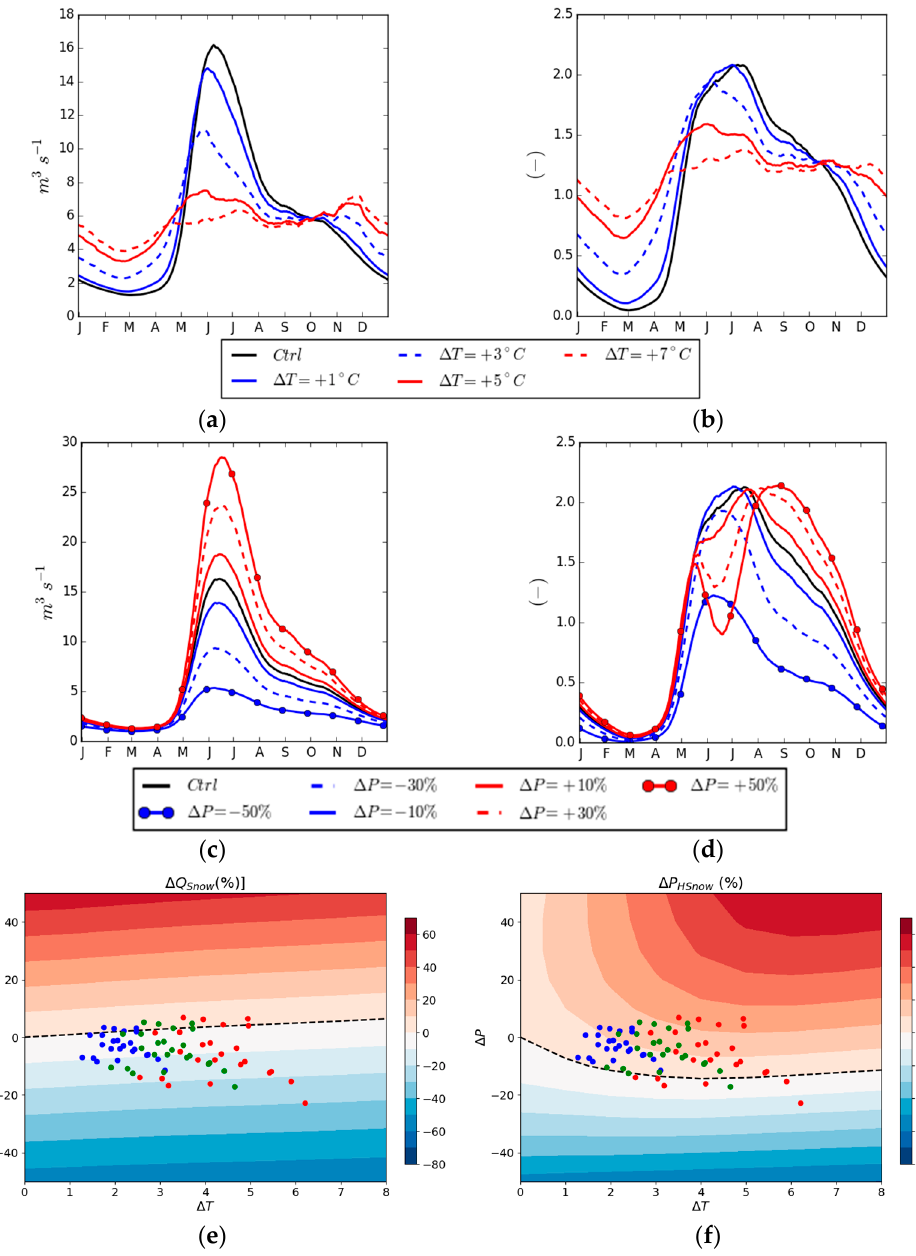
Figure 7. Same as Figure 6 for Cadipietra catchment.